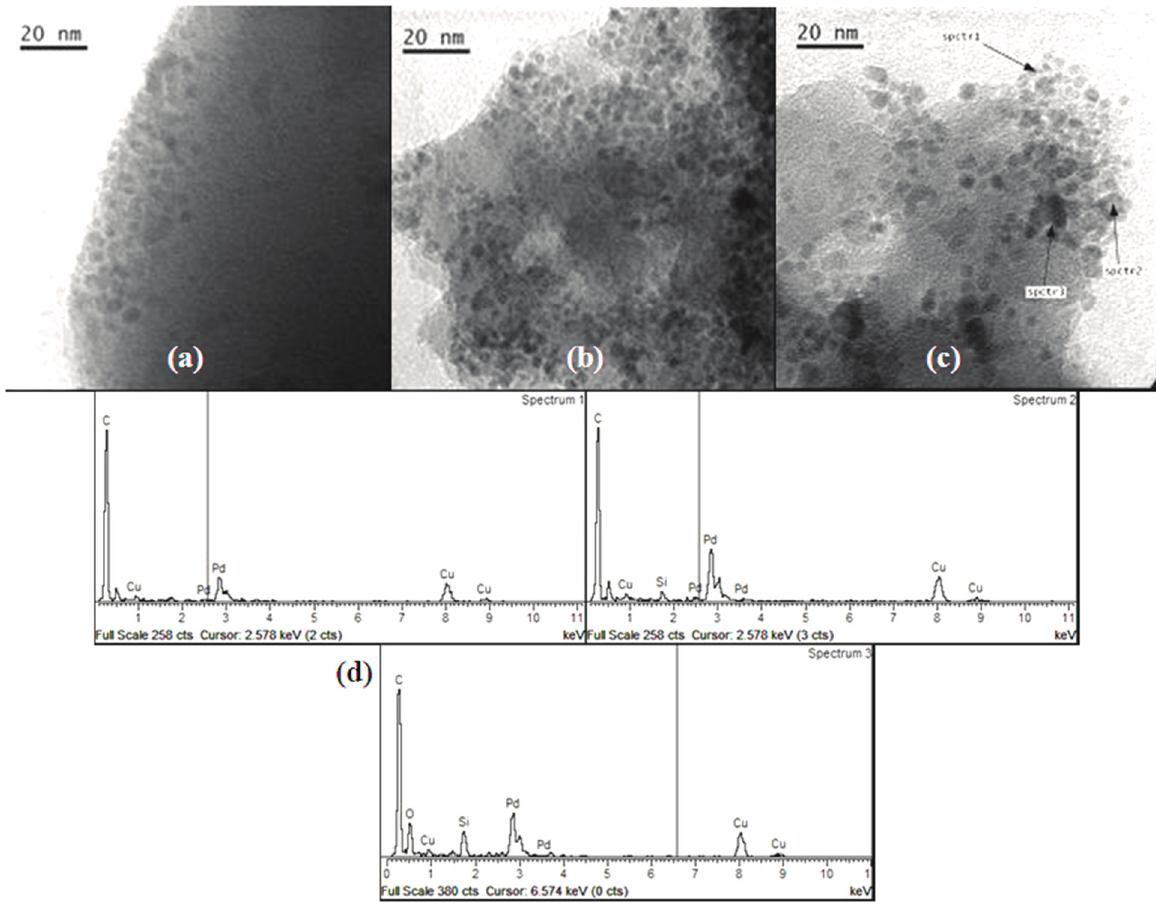
Figure 6. TEM bright field images of Pd-pol after ( a ) 5 min of the first cycle; ( b ) the first cycle and ( c ) the fifth cycle of the TBAB assisted Suzuki-Miyaura cross-coupling reaction described in entry 2 of Table 1; ( d ) EDS spectra of selected areas of ( c ) (irregular contamination of silica was observed in Spectrum